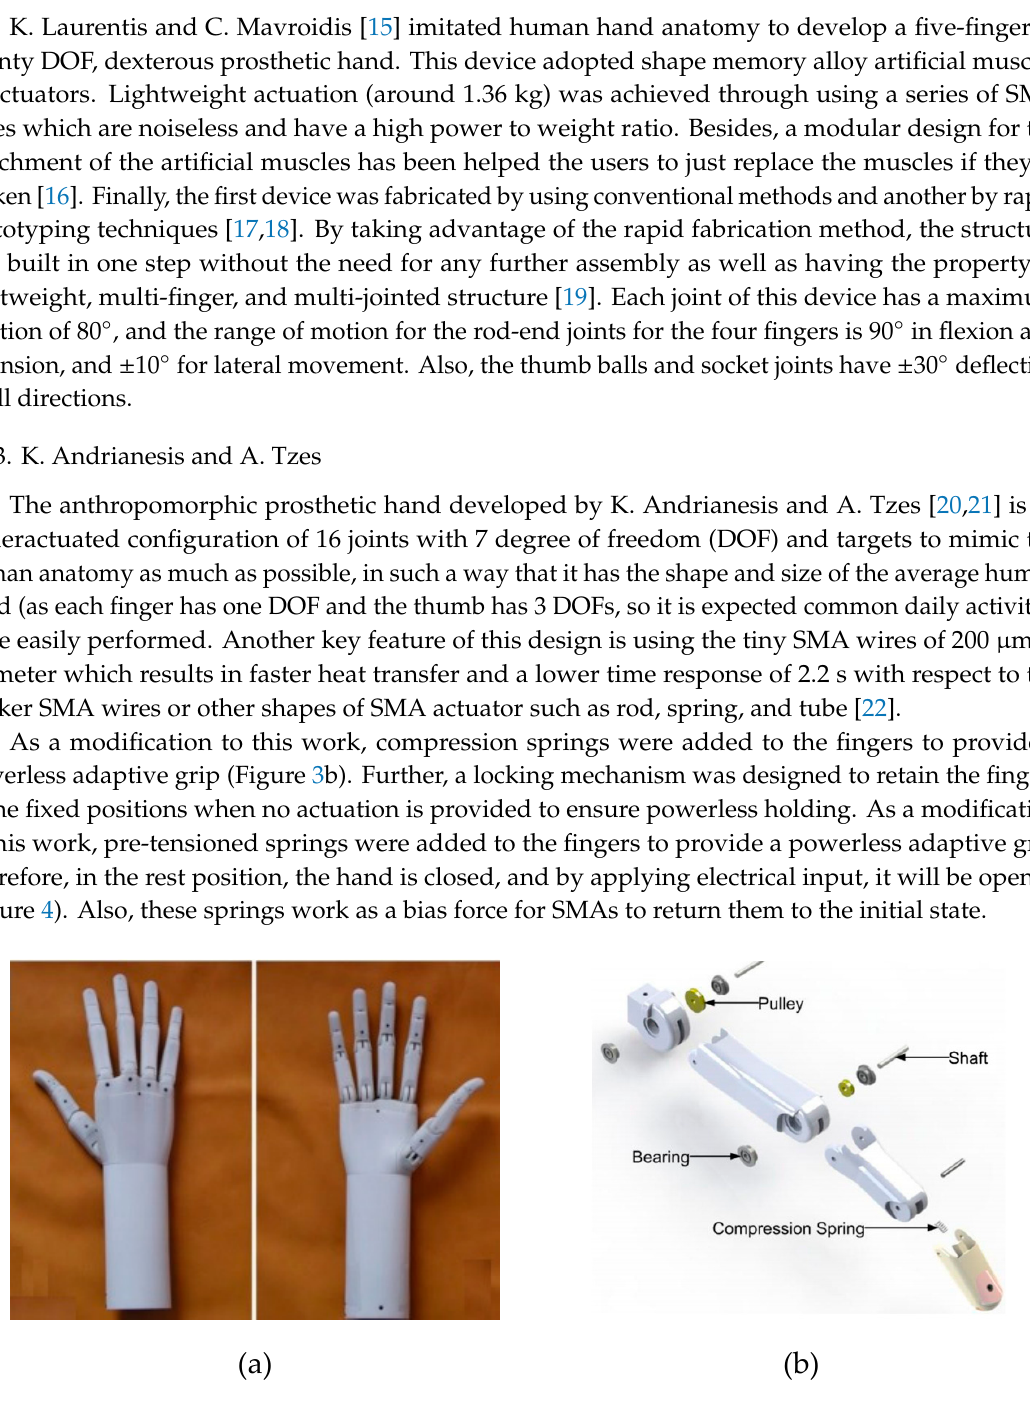
Figure 3. The humanoid prosthetic hand designed by K. Andrianesis and A. Tzes. ( a ) Prototype of the prosthetic hand ( b ) Exploded representation of a finger mechanism [21] .